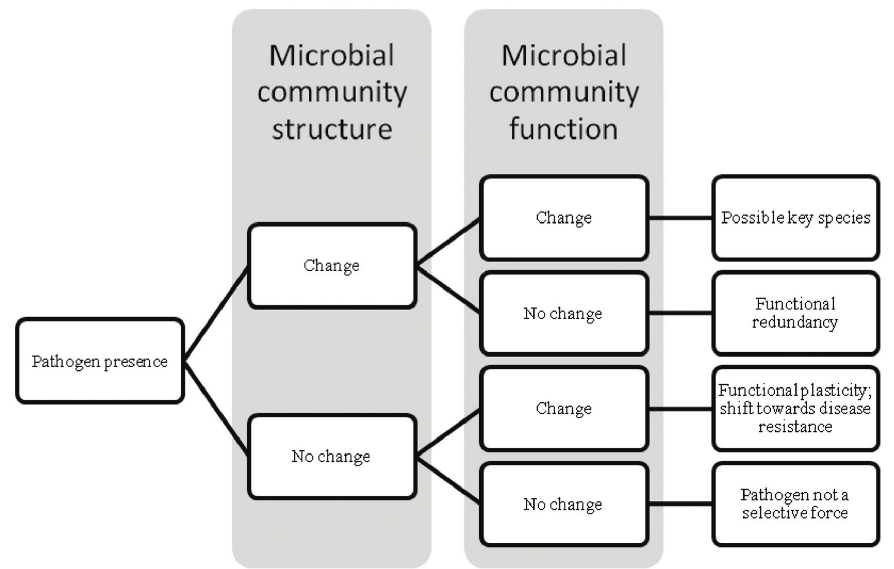
Fig 1. Conceptual model representing potential responses and interpretations of microbial community structure and function in the presence of a pathogen.